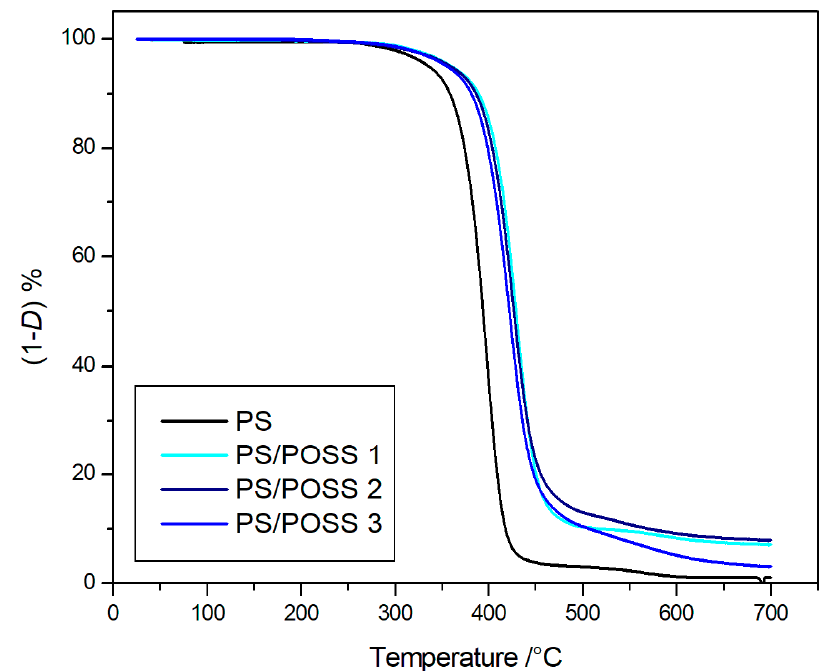
19.3 A difference between the actual POSS contents in the obtained samples and the theoretical content was observed, which could be explained by an oligomers formation in the reactant mixtures [40]. These oligomers, which are soluble in methanol, remained in the solution, thus resulting in a